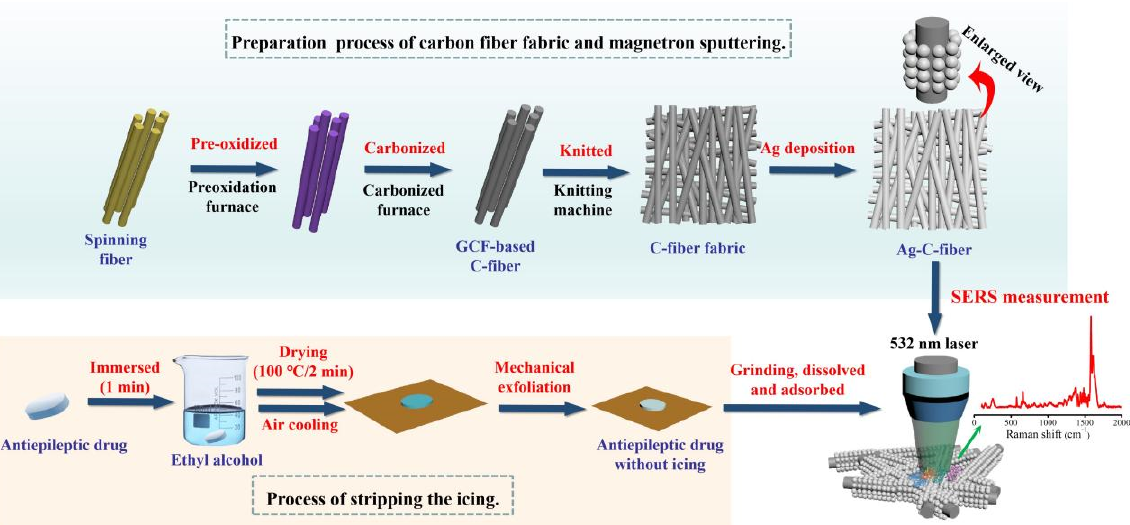
Figure 1. Illustration of fabrication of Ag-C-fiber and used for antiepileptic drug sensing by